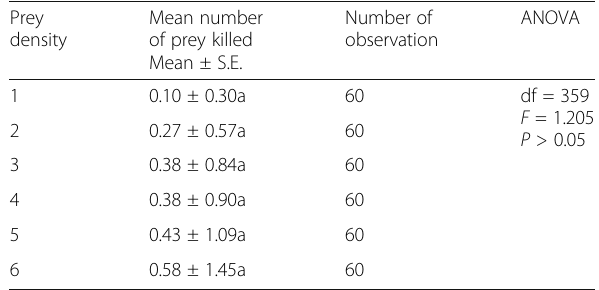
Table 1 Mean number of P. truncatus larvae killed in 24 h by A. biannulipes in function of density